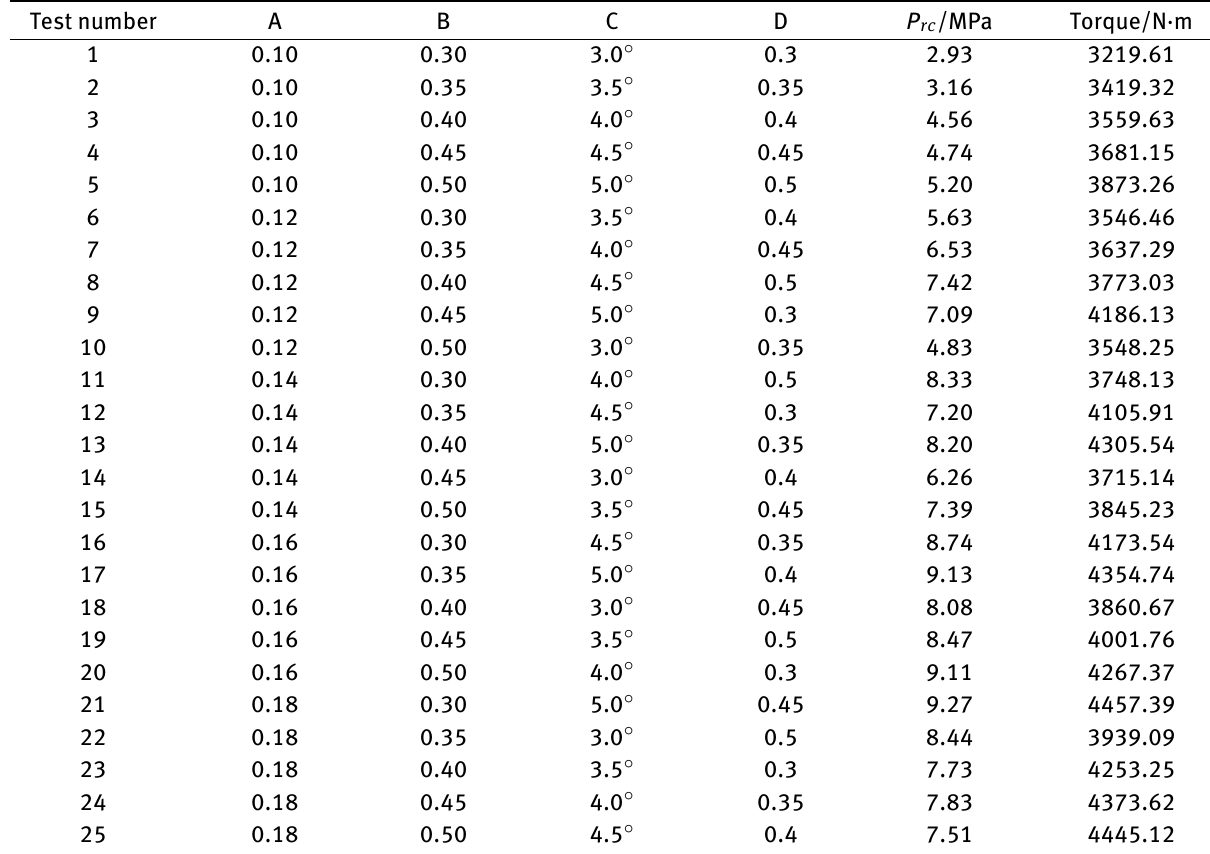
Table 1: Scheme of orthogonal experiment Test number